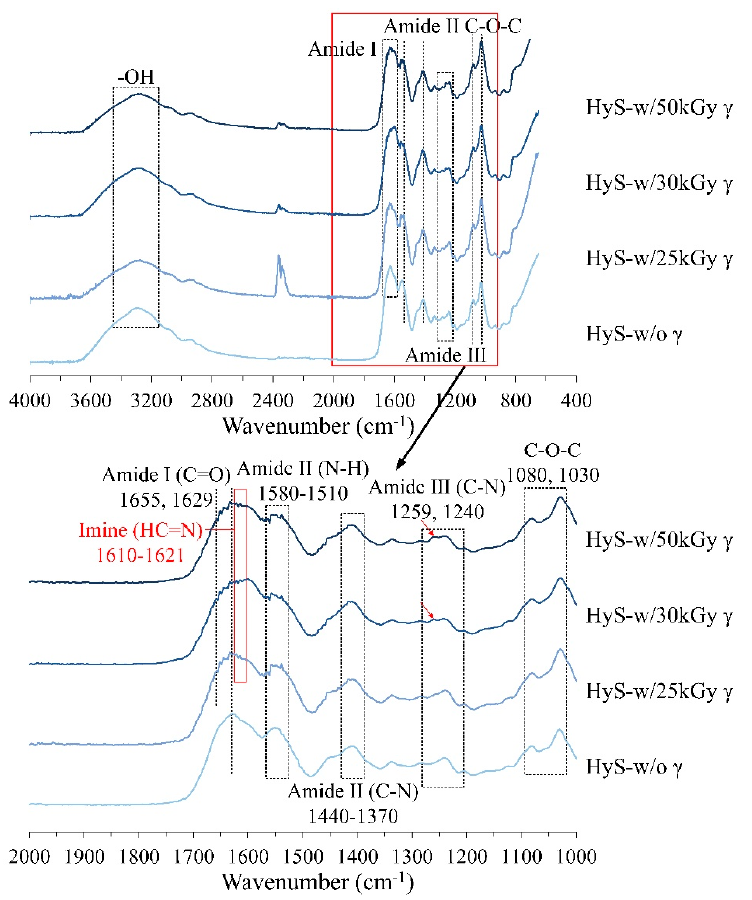
Figure A1. Full and specific absorption bands were obtained through the ATR spectrum analysis of macrospheres before (HyS-w/o γ ) and different γ -radiation kGy after (HyS-w/ γ ) sterilization.